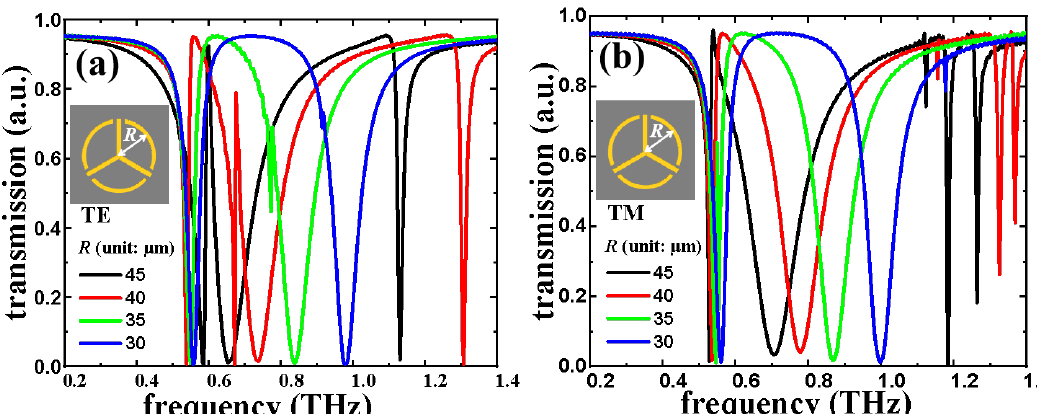
Figure 6. Electromagnetic responses of TTM by changing the R parameter in ( a ) TE and ( b ) TM modes under the condition of L = 47.5 μm.